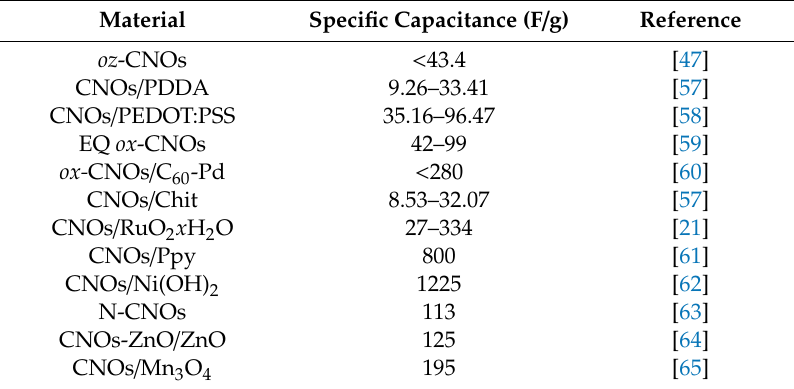
Table 3. Specific capacitance values obtained for the CNO